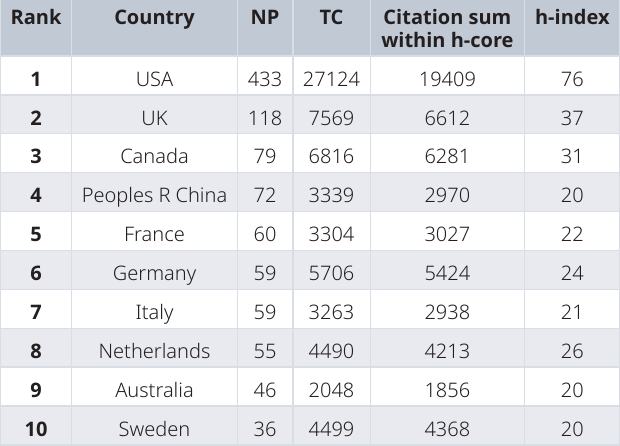
Table 4. Top ten country-wise research in autism.